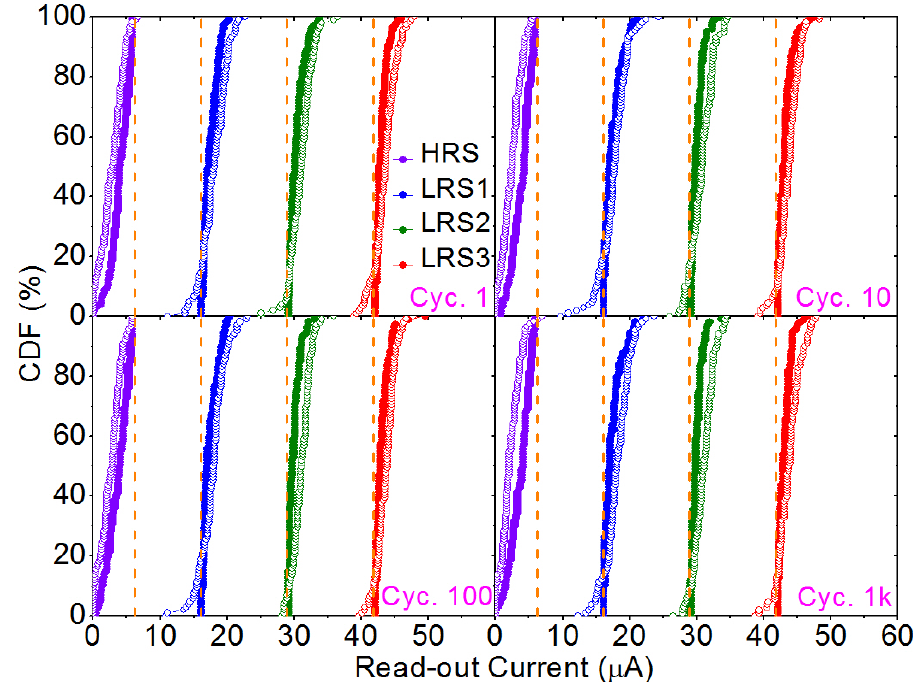
Figure 3. CDFs of the read-out currents experimentally measured just after the switching transition (solid symbols) and at the end of the M-ISPVA (open symbols) logarithmically sampled (1, 10, 100, and 1 k cycles) during the 1 k cycles endurance test for the four optimized conductive